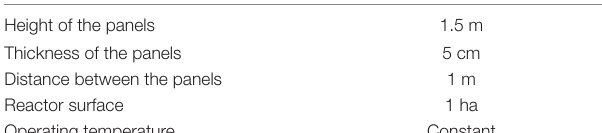
TaBle 2 | Flat panel photobioreactor characteristics.